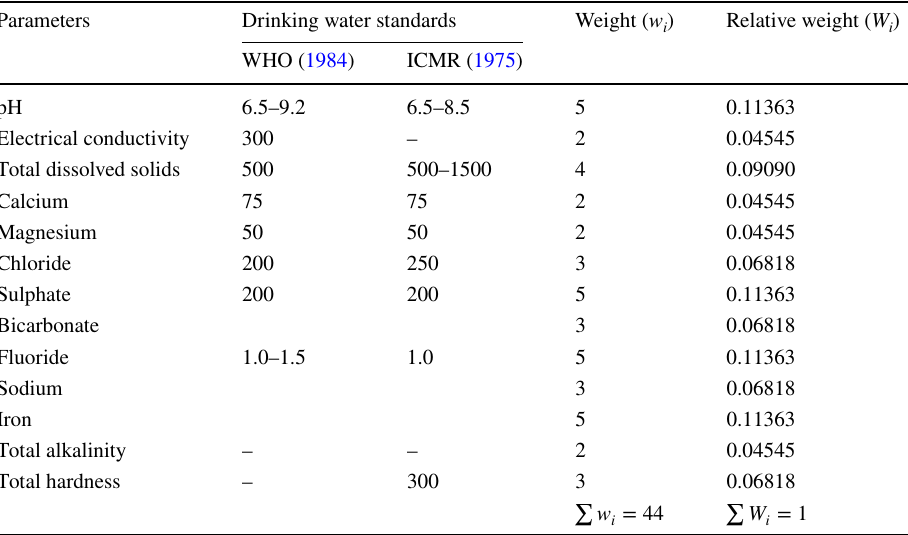
Table 6 Relative weight of chemical parameters for WQI index